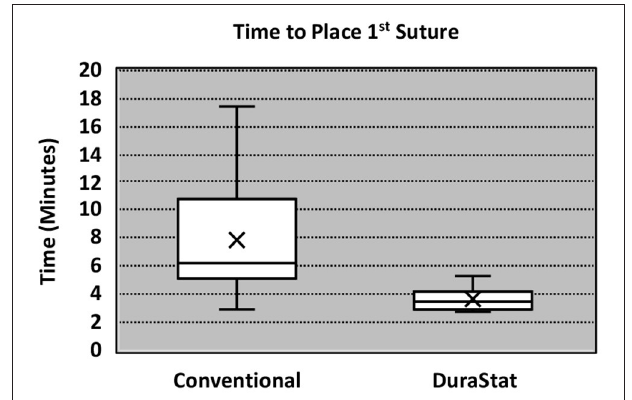
FIGURE 2 | Boxplot of time to place 1st suture.